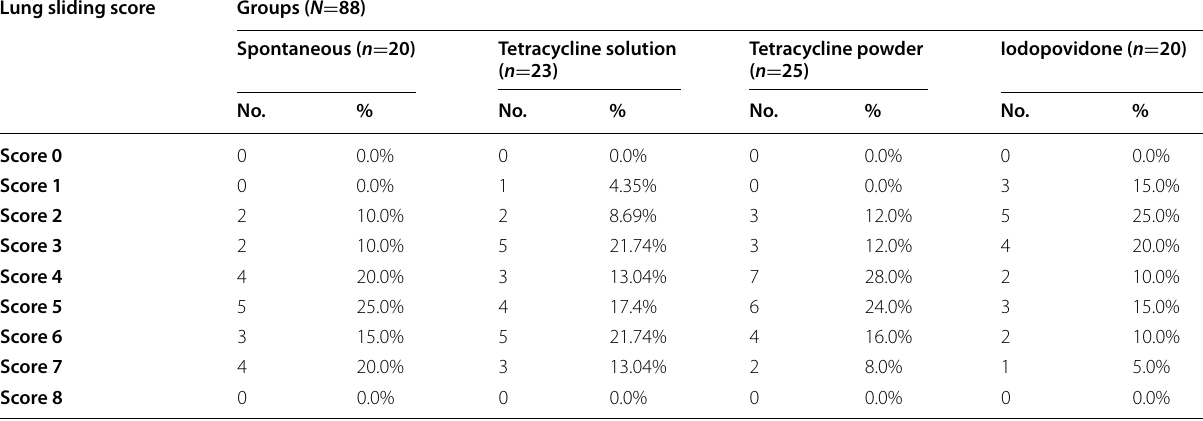
Table 5 Comparison between the four groups as regards lung sliding score 1 month after pleurodesis Lung sliding score